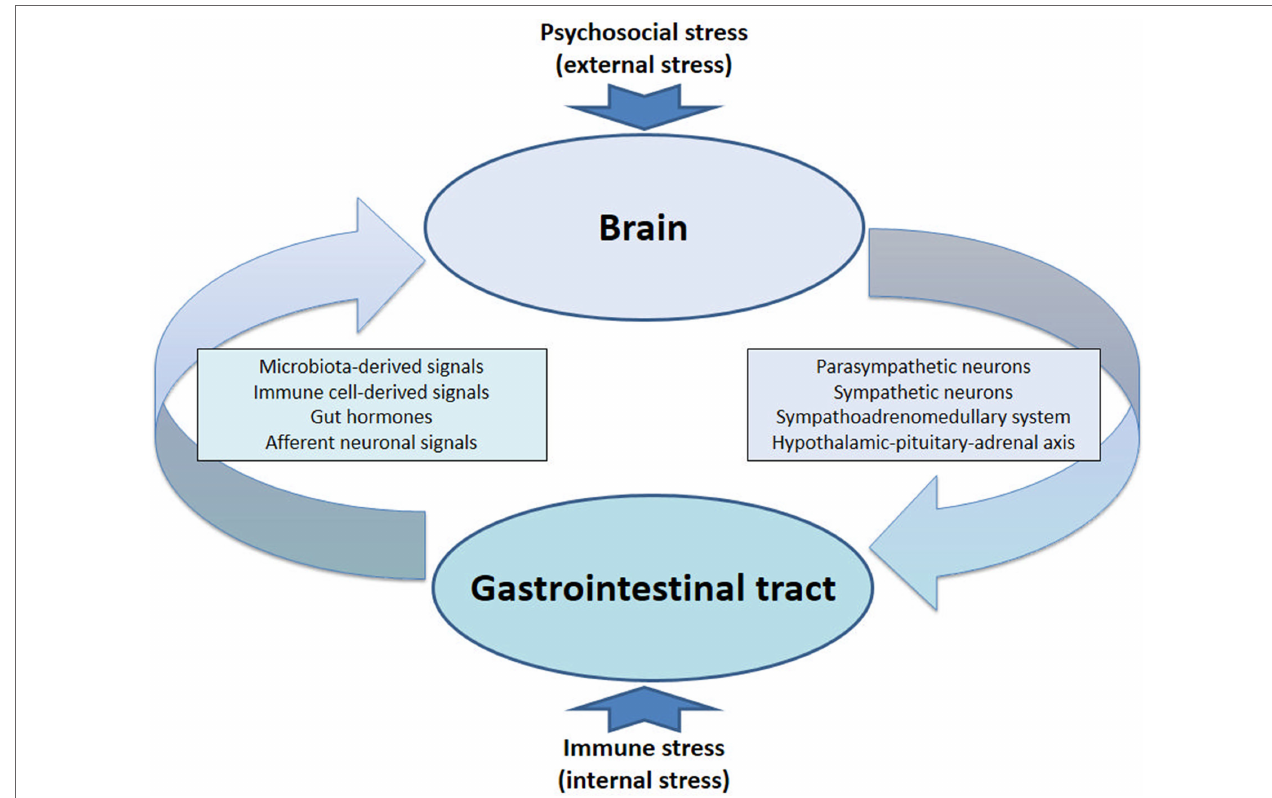
FiGURe 2 | The circle completed: bidirectional communication between gut and brain under conditions of stress. The stressed brain facilitates immune activation and inflammation in the gut, while immune stress in the gut and periphery feeds back to the